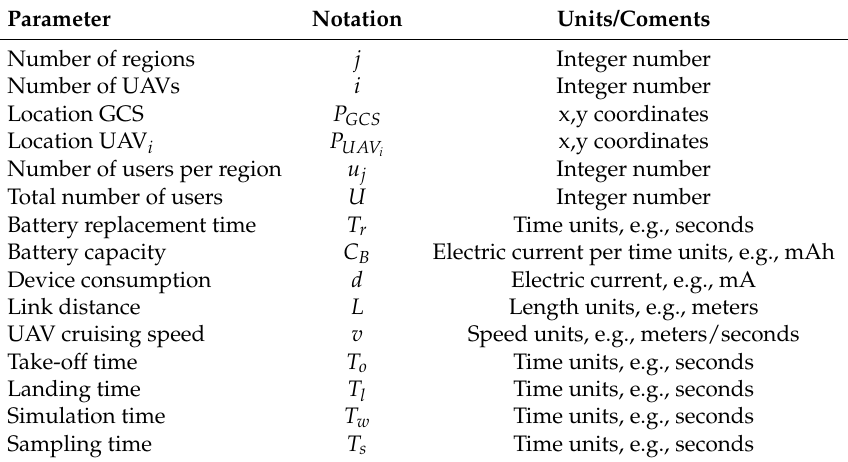
Table 1. System parameters.